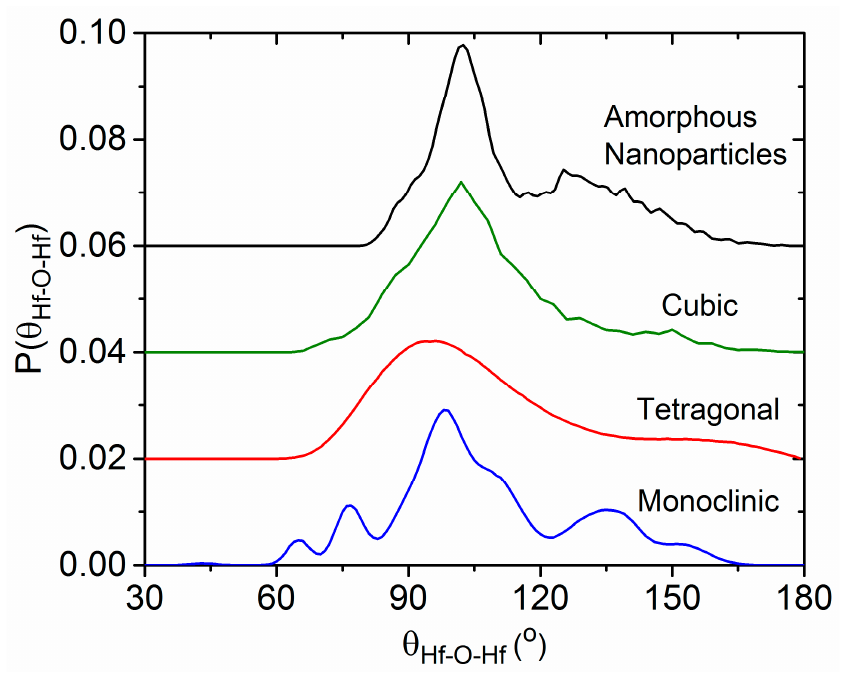
Figure 11. Distribution of bond angles monoclinic, tetragonal, and cubic HfO 2 structures obtained from molecular dynamics simulations.